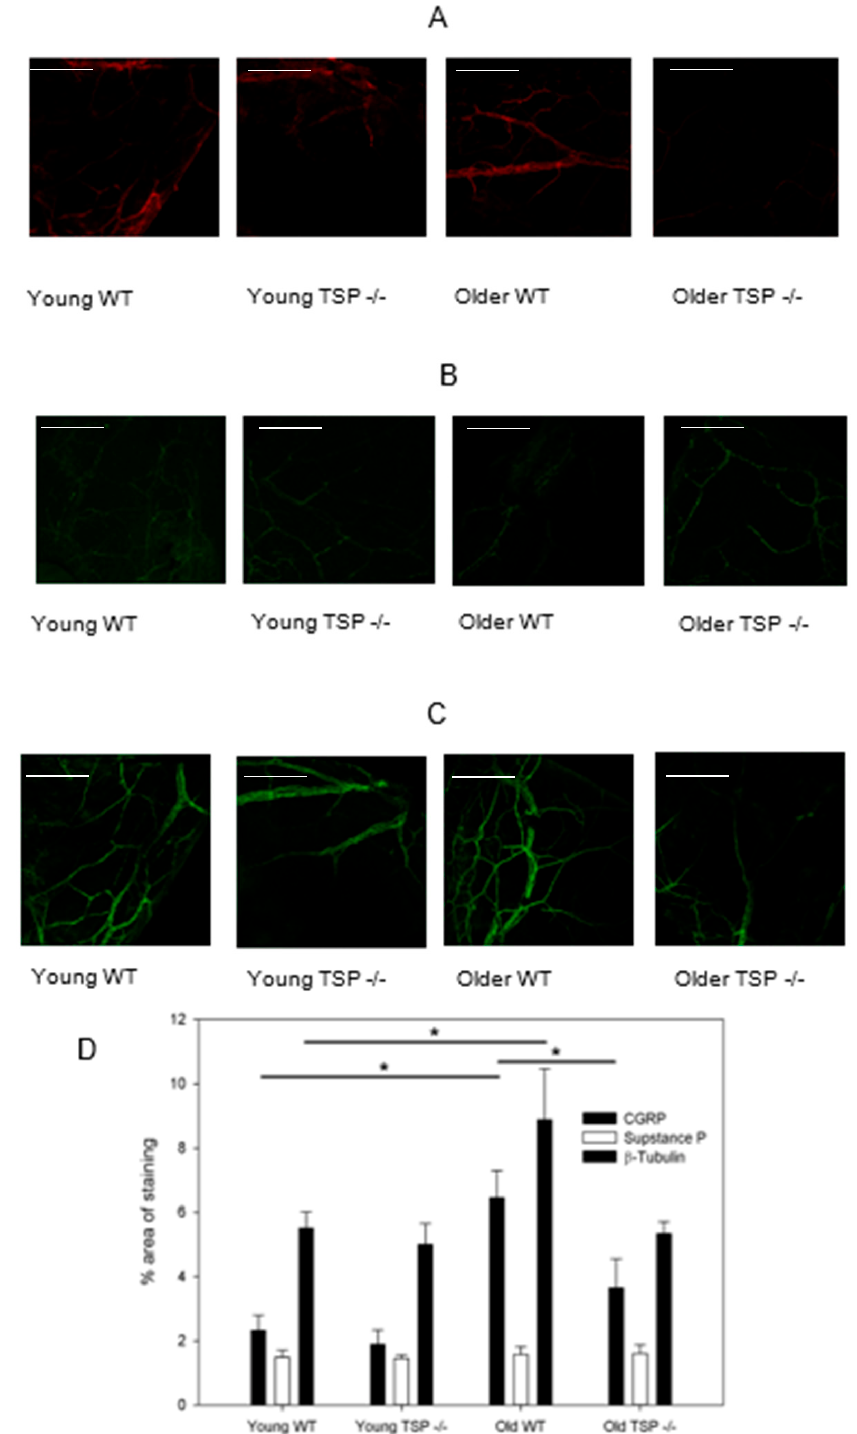
Figure 6. Examination of calcitonin gene-related peptide (CGRP)- ( A ) and Substance P (SubP)- ( B ) containing cells in WT and TSP-1 − / − mice by in vitro immunofluorescence microscopy analysis. The average percent area signaling for the protein of interest was measured using ImageJ (Fiji) due to the discrete nature of neurotransmitter-containing vesicles. The percent area of staining was also examined for β -tubulin staining ( C ) and compared across groups ( D ). n = 6 for all conditions. Scale bars represent 300 µ m and * denotes a significant difference.